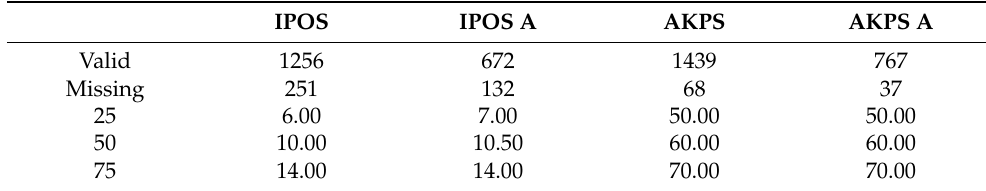
Table 2. Quartile breakdown of all IPOS and AKPS scores and after aggregation (A) by patient.